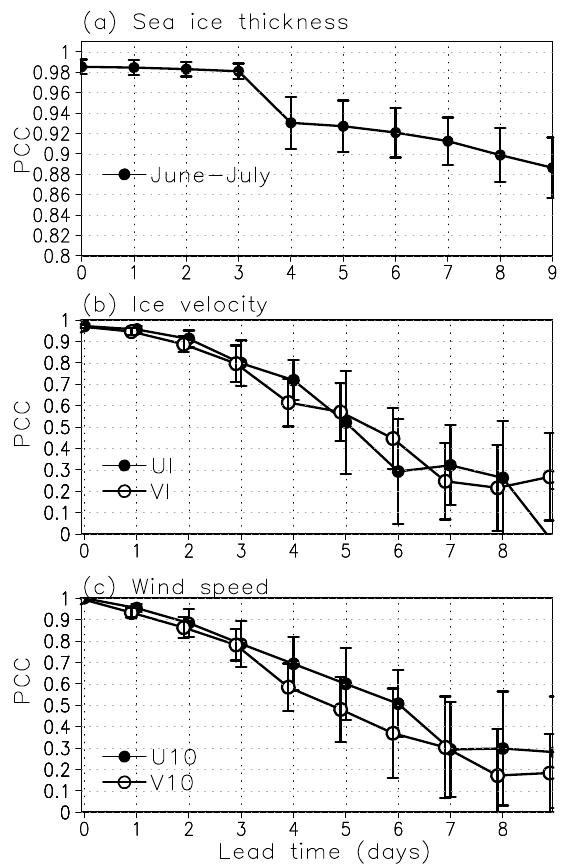
Figure 7. PCCs between forecast and analysis (a) SIT, (b) zonal and meridional ice speed, and (c) zonal and meridional surface wind speed from operational TOPAZ4 data in early summer (June–July) averaged over 2014–2016. Error bar indicates the standard deviation of the